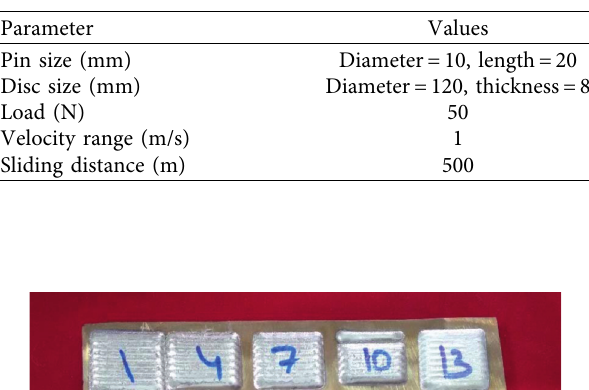
Table 5: Pin-on-disc wear test parameters